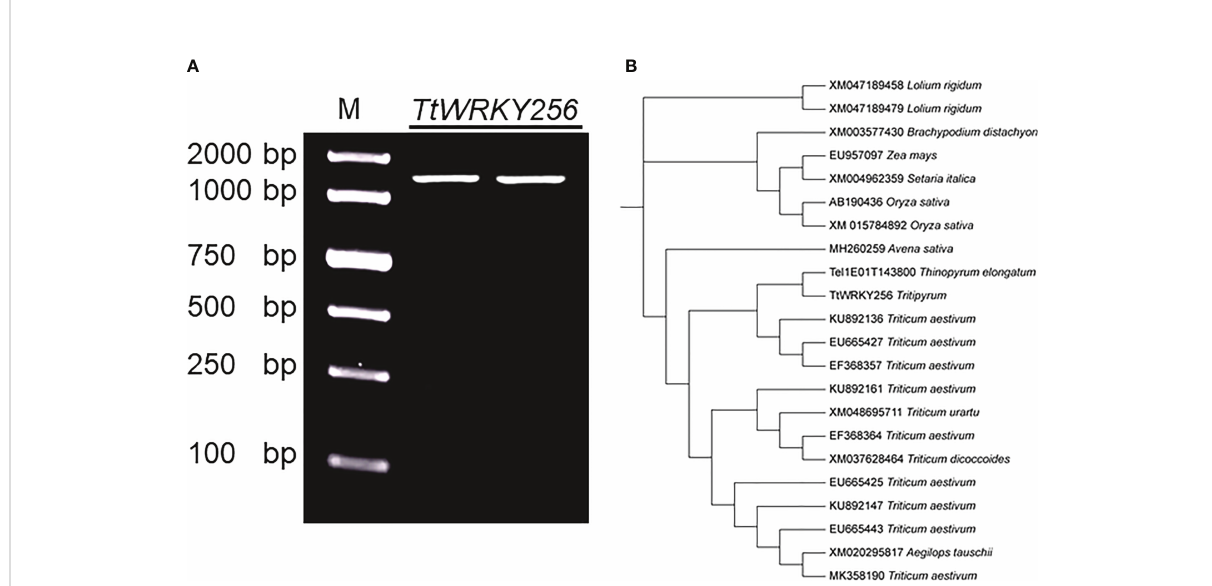
FIGURE 7 Clone and Phylogenetic relationships of TtWRKY256. (A) Ampli fi cation products using ‘ Y1805 ’ cDNA; (B) Phylogenetic tree of WRKY nucleic acid sequences in various plant species. The Maximum Likelihood (ML) tree was generated using MEGA X with 1000 bootstrap